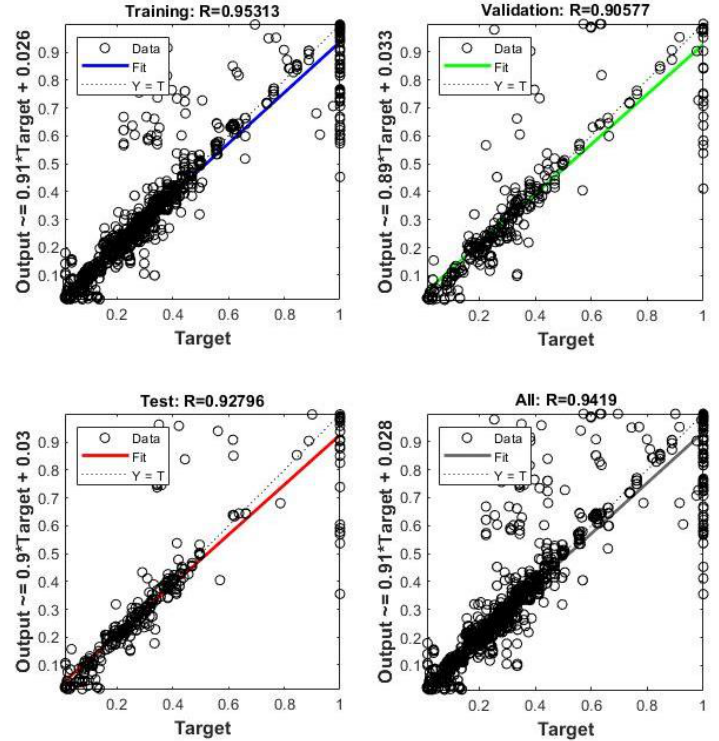
Figure 8. R values of the Training, Validation, and Test of ANN for acceleration